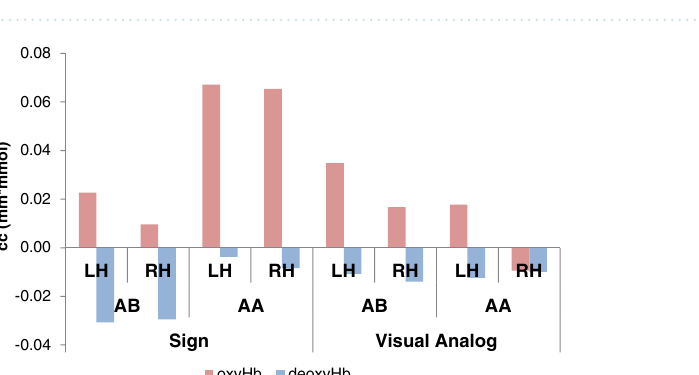
Figure 3. The grand average hemodynamic responses obtained in Experiment 2. Plotting conventions are the same as for Fig. 2 with the exception that the shaded areas showing significant differences in the permutation test between the two conditions are color coded to indicate separately differences occurring during the initial undershoot of the hemodynamic response (light gray) and the peak/plateau of the hemodynamic response (dark gray).